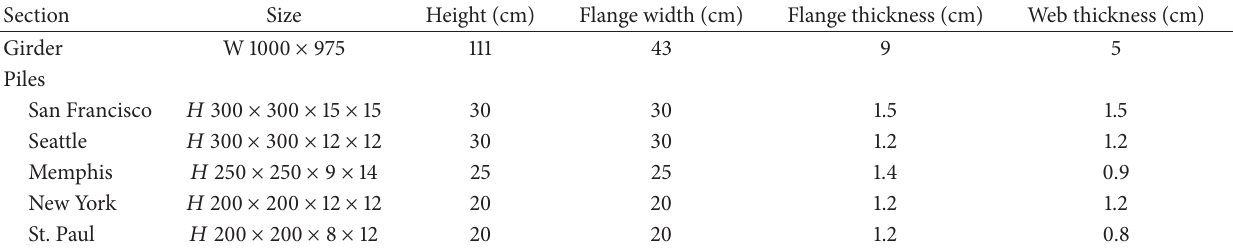
Table 5: Steel sections properties.